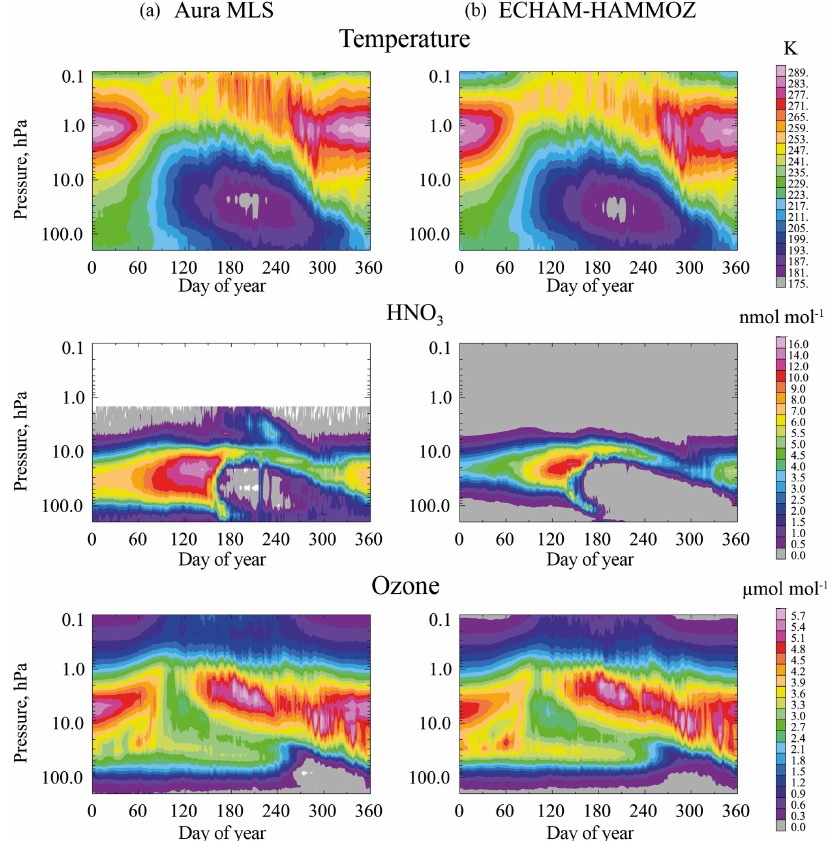
Figure 4. Comparison of temperature, HNO 3 , and O 3 between Aura MLS observations (a) and ECHAM-HAMMOZ (b) . Data and model are for the year